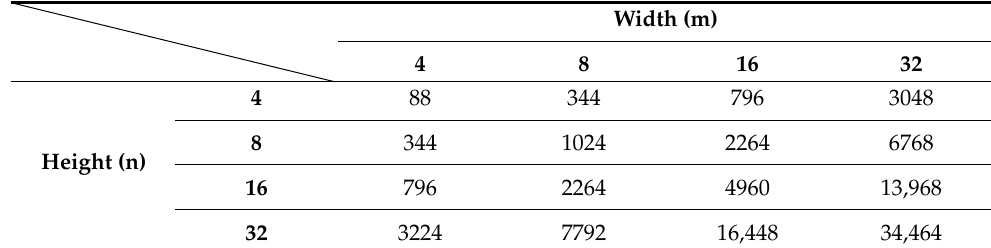
Table 4. The number of additions when the horizontal and vertical transforms are combination of DST-VII and DCT-VIII in the VTM-8.2.